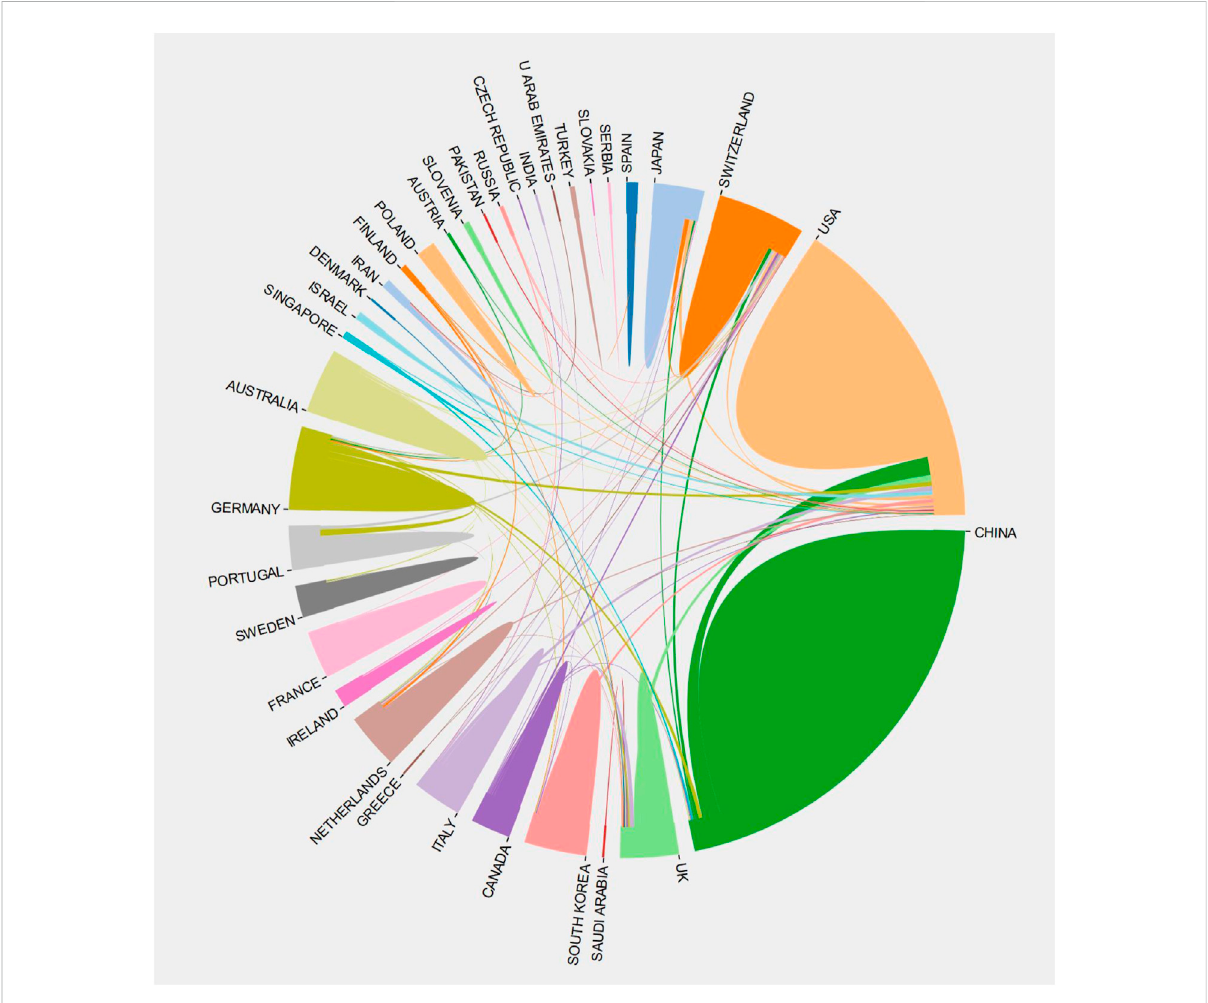
FIGURE 4 Inter-country cooperation chord chart display (take WOSCC as an example). The larger the area the greater the number of national publications,andthethicker theline thestrongerthelinks.It canbeseen thattheWesterncountries, ledbytheUS,weremore closelylinkedto each other, and although China and the United States were closely linked, there was still a lack of multi-national cooperation with